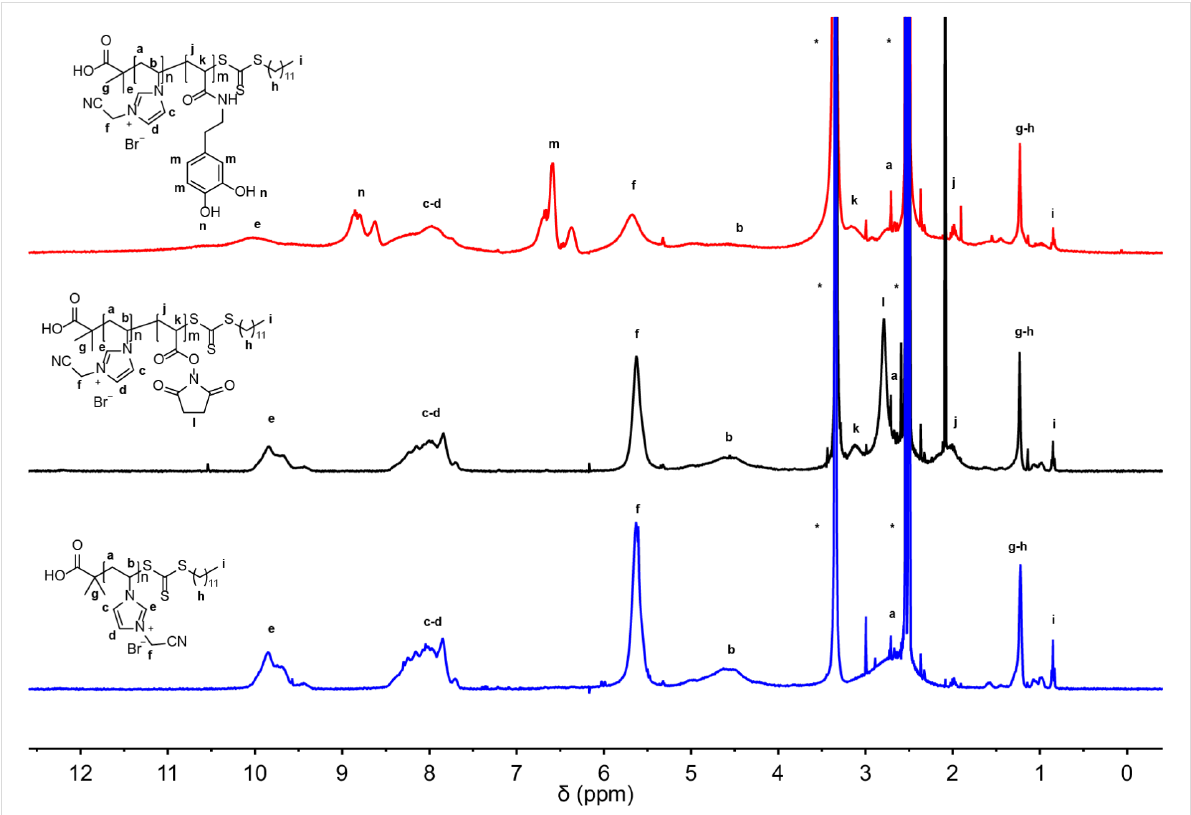
Figure 3: 1 H NMR spectrum of P1 , P2 and P3 , all measured in DMSO- d 6 . In blue the spectrum of the PIL block is shown. The black spectrum belongs to the block copolymer with the reactive ester block. At 2.8 ppm a new shift can be seen, which is dedicated to the succinimide group in the reactive ester. The spectrum in red shows the polymer after the post-polymerization step. The shift at 2.8 ppm from the reactive ester disappeared. At 6.5 ppm and 8.8 ppm the chemical shifts from the dopamine group are